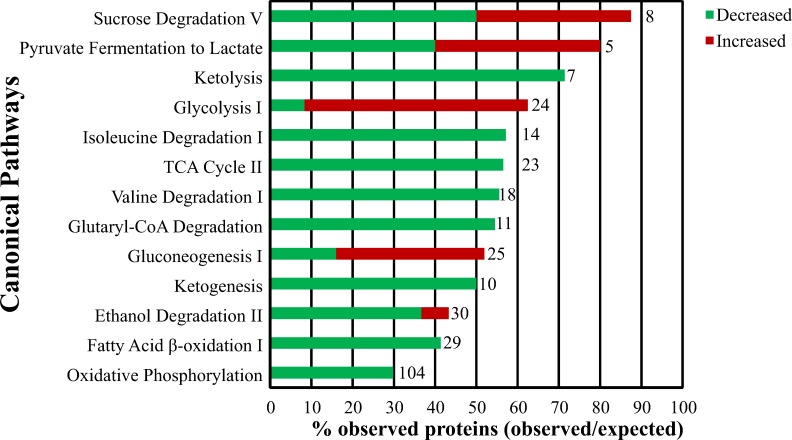
Enriched pathways related to metabolic dysfunction in ccRCC.Pathway enrichment analysis using IPA was performed using the 344 proteins with differential abundance between normal and tumor samples. Of the 88 pathways identified at an FDR < 5% and containing more than one protein, the following top 13 pathways are shown based on their relationship to Warburg effect related changes. The ratio of enrichment (or % observed) is further divided into those proteins increased or decreased in tumor samples. The total number of possible (or expected) proteins in each pathway is given to the right of the bar.